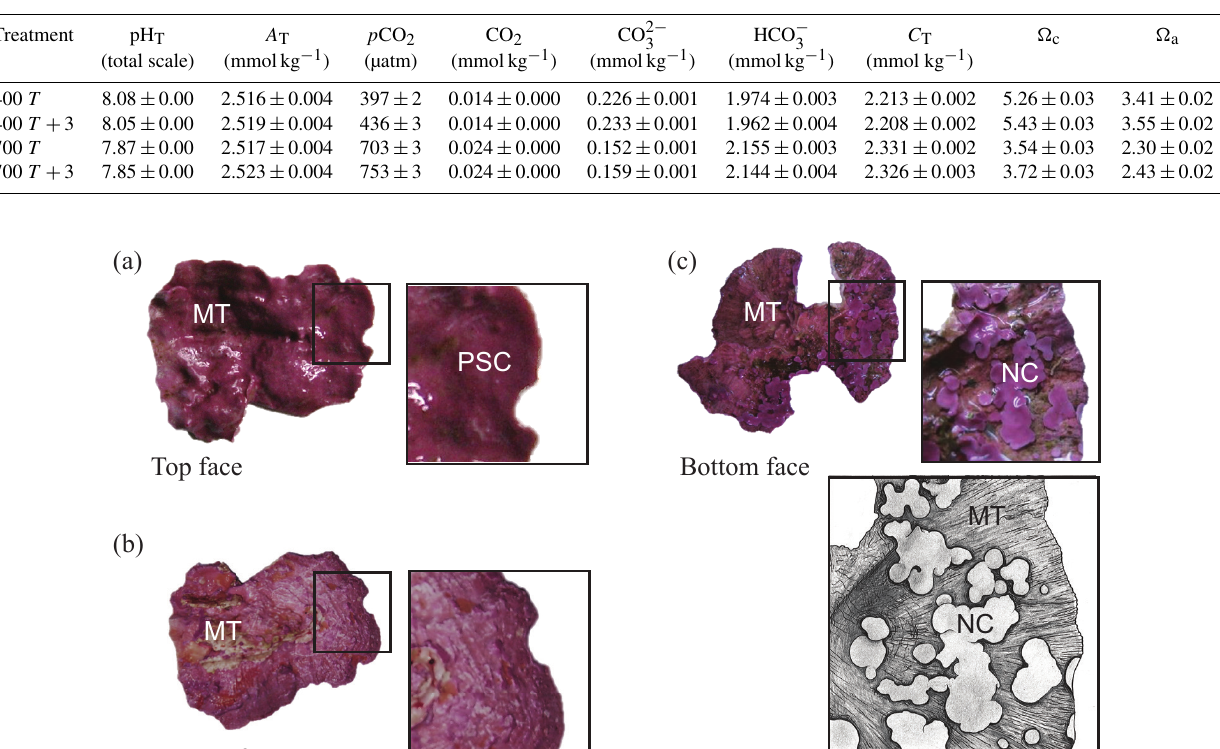
Table 1. Parameters of the carbonate system in each treatment. The values reported are means ( ± standard error) of 191 to 194 data collected from July 2006 to August 2007. The pH (pH T , on the total scale) and total alkalinity ( A T ) were measured while other parameters were calculated. p CO 2 , CO 2 partial pressure; C T , dissolved inorganic carbon; (cid:127) c and (cid:127) a , saturation state of seawater with respect to calcite and aragonite.